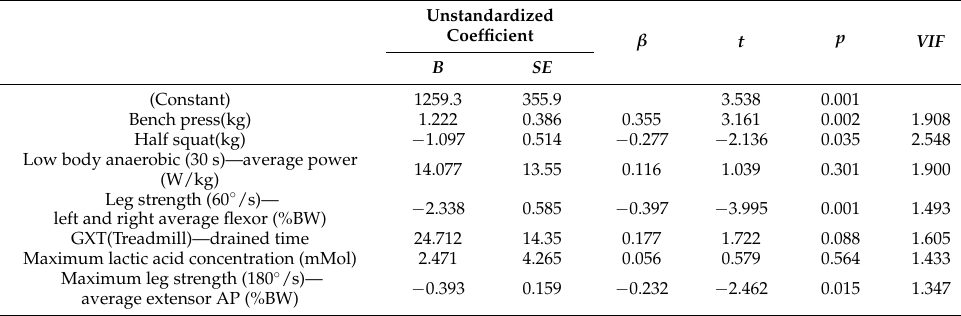
Table 8. The effect of specific fitness factors on overall